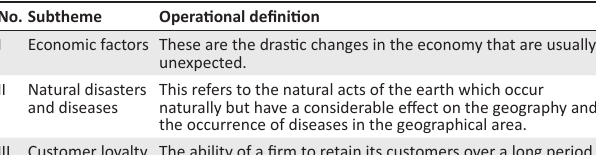
TABLE 4: Operational definitions for supply chain